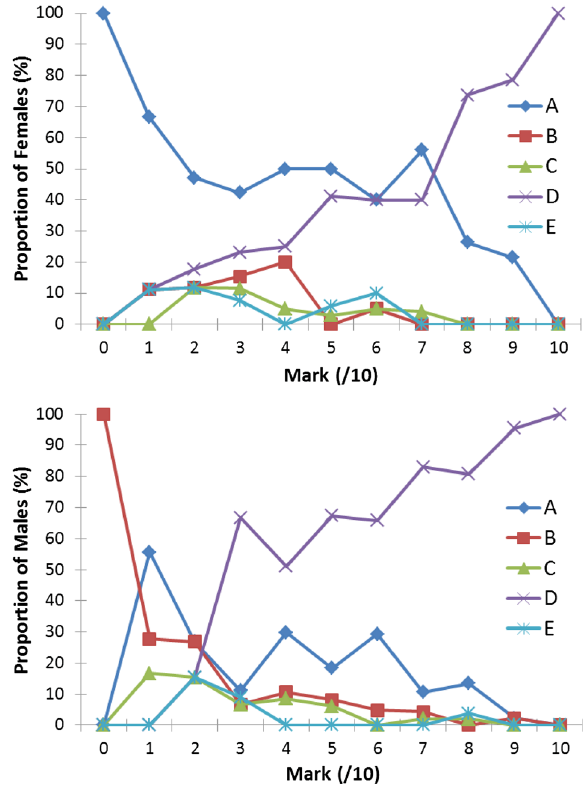
FIG. 5. Item response curves for question 9 of the 2012 ASOE, Projectile motion in two dimensions, for females (top) and males